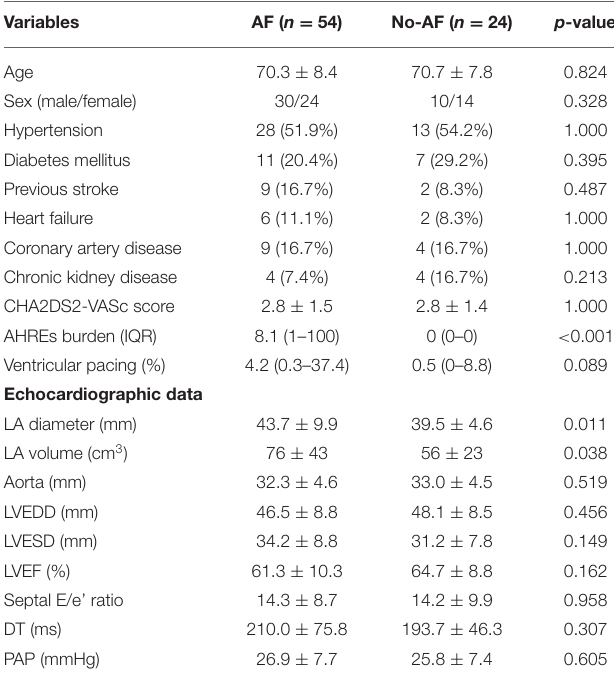
TABLE 1 | Baseline characteristics of the 78-subject study